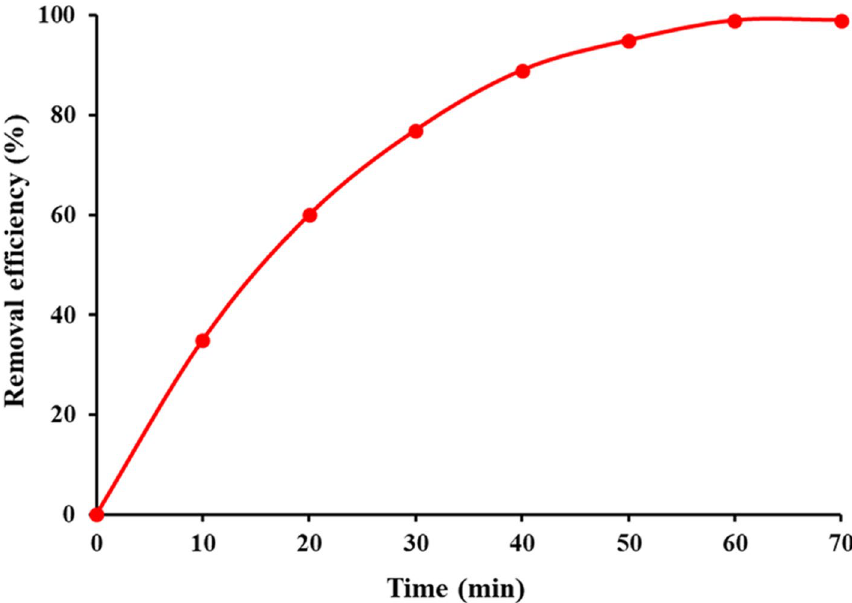
Figure 11. Mineralization and removal efficiency of MB dye as a function of time in the presence of CeO 2 nanophotocatalyst with sunlight